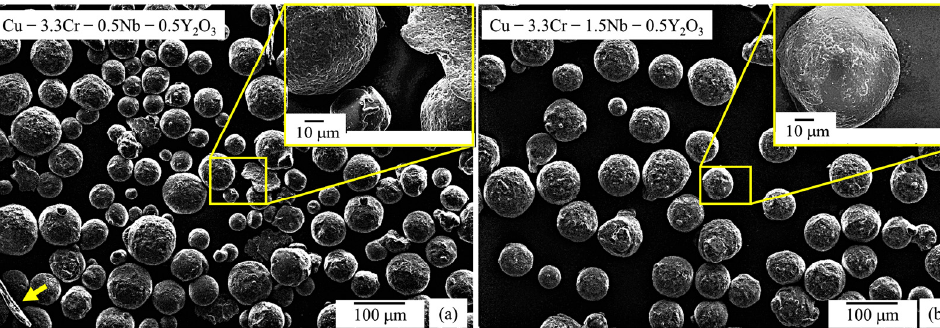
Figure 2. SEM images (SE mode) of gas-atomized powder particles with superimposed SEM image with higher magnification: ( a ) Cu-3.3Cr-0.5Nb alloy. ( b ) Cu-3.3Cr-1.5Nb alloy. The Cu-3.3Cr-1.5Nb powder material (Figure 2b) shows a comparably high fraction